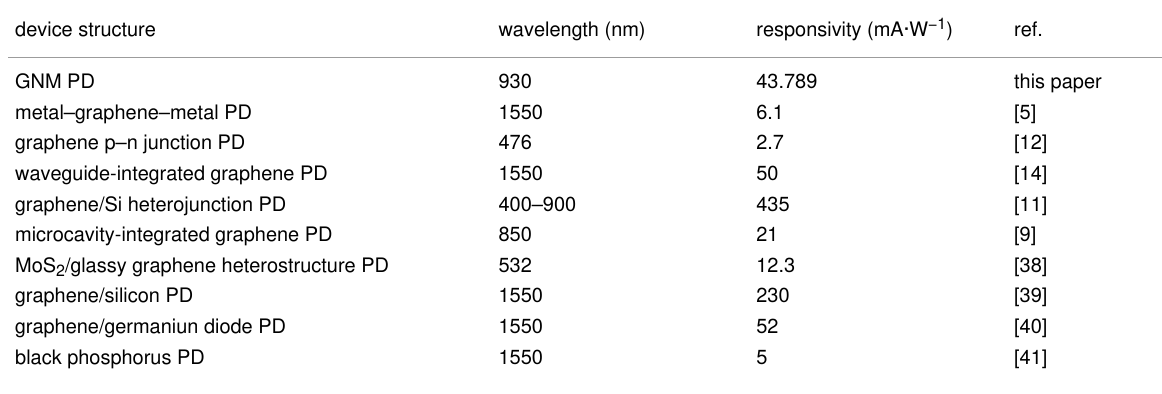
Table 3: Responsivity of several